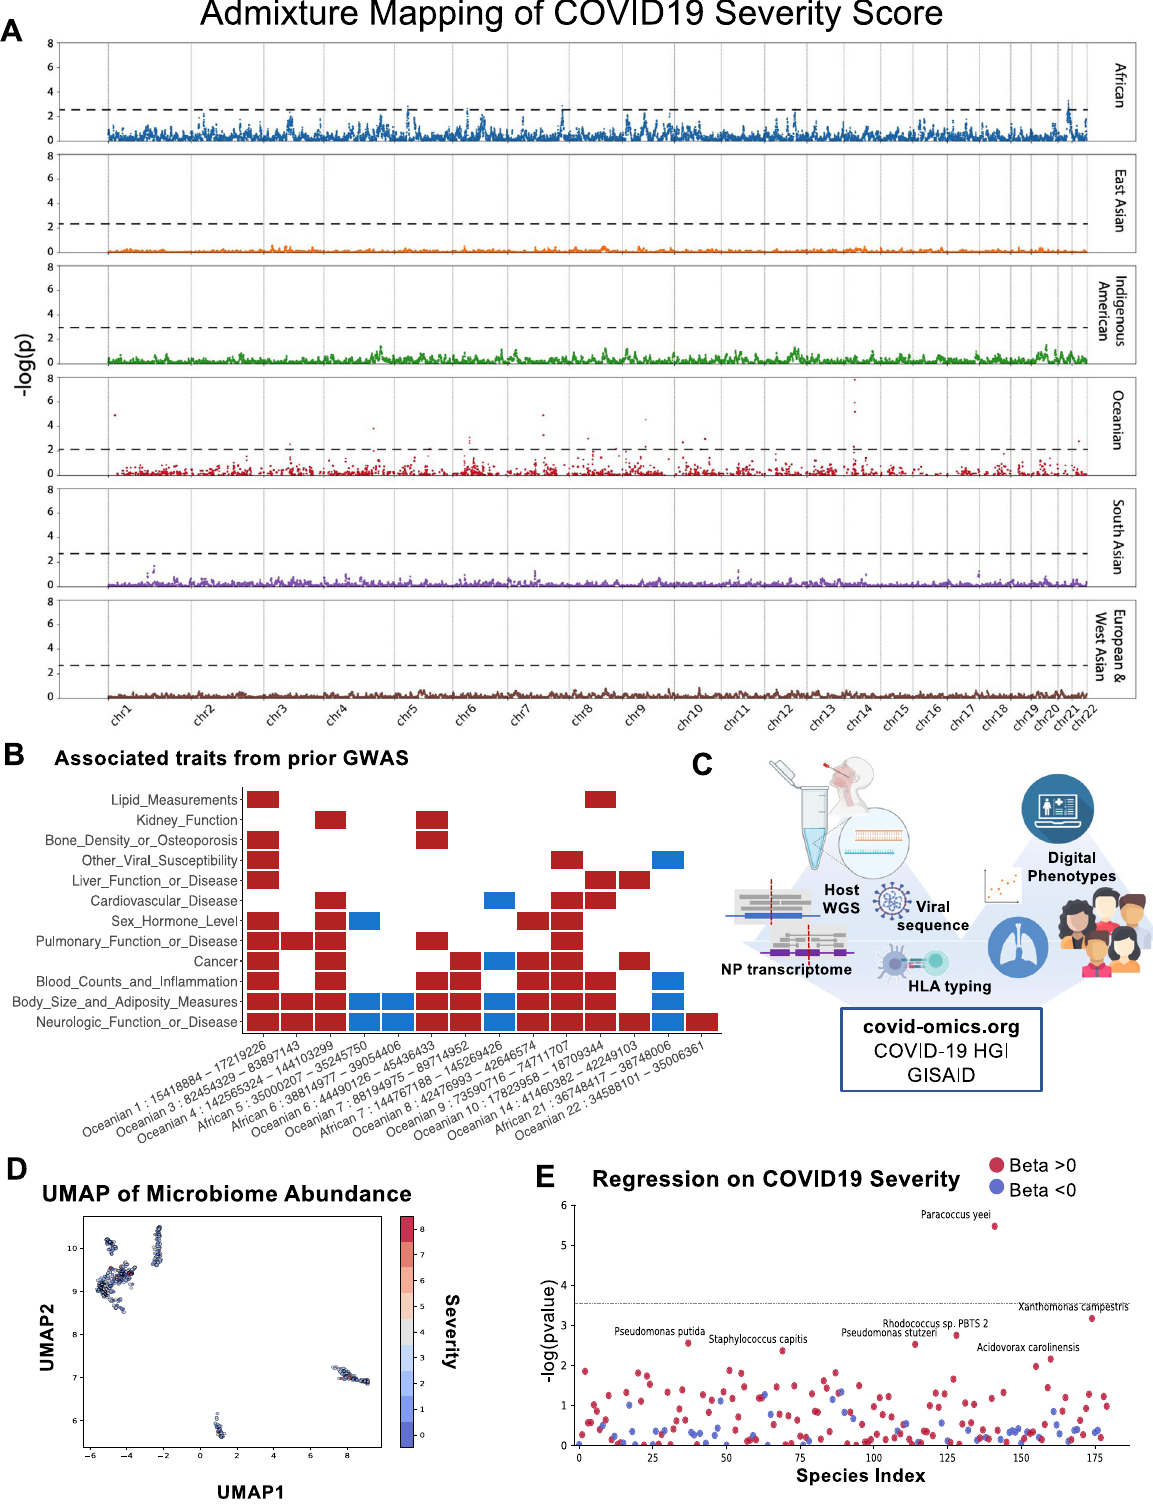
Fig. 2 | COVID-19 severity is associated with local-ancestry-speci fi c risk loci via admixture mapping, and is also correlated with metagenomic features of the NP transcriptome. A Ancestry-speci fi c risk loci found in African and Oceanian ancestries, respectively after correcting for overall genetic ancestry proportion, BMI,sex,andage.Eachcoloreddotrepresentsawindowofthegenome.Blacklines representancestry-speci fi cthresholdsdeterminedbythemethodofShrineretal. 19 Thresholds determined by running one thousand association tests on random permutations of case-control labels are displayed in Figure S5. B Traits associated with genomic regions statistically enriched for disease severity in the GWAS